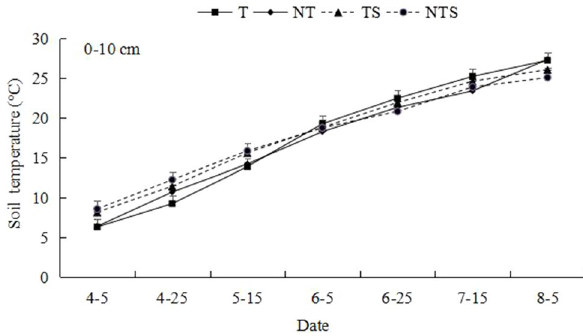
Figure 2. Temperature of 0–10 cm soil layer under different tillage measures.